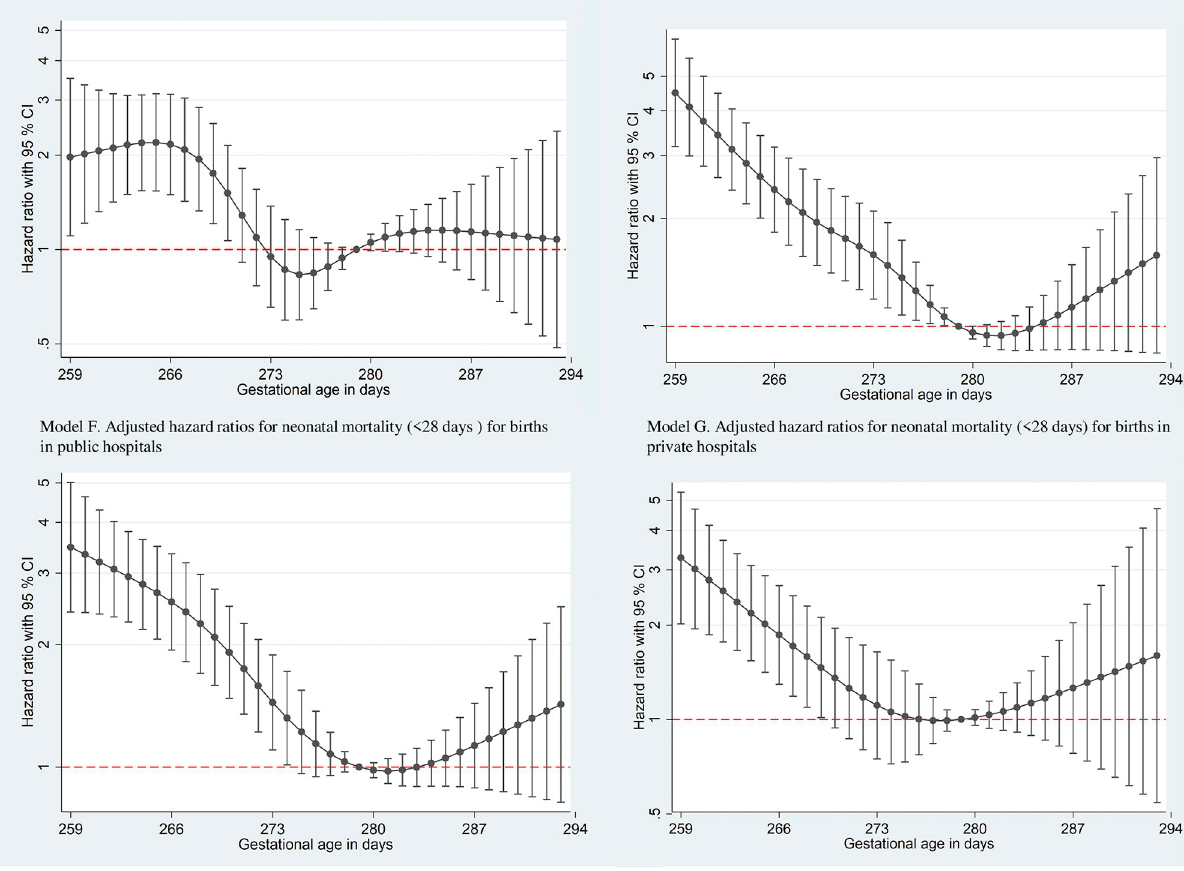
Fig 3. Hazard ratios (HRs) for neonatal mortality adjusted for maternal variables and number of antenatal care visits. Models (D) and (E) stratified according to type of birth. Models (F) and (G) stratified according to type of hospital.